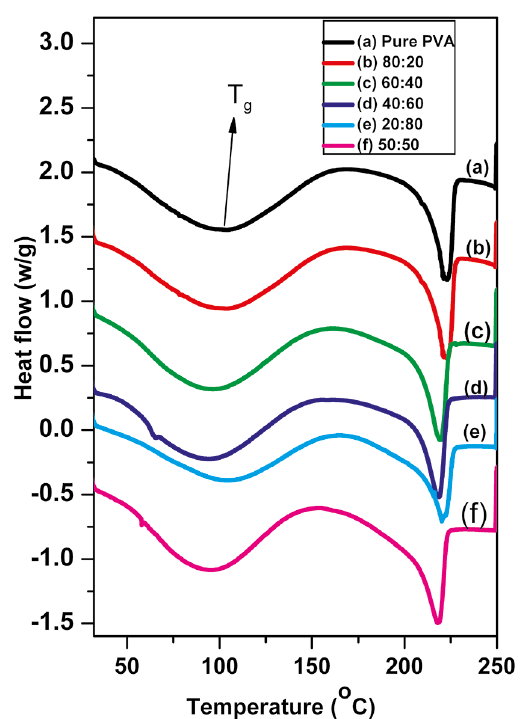
Figure 4. DSC curves of (a) Pure PVA and PVA/MAA:EA blend sample (b) 80:20 (c) 60:40 (d) 40:60 (e) 20:80 (f)